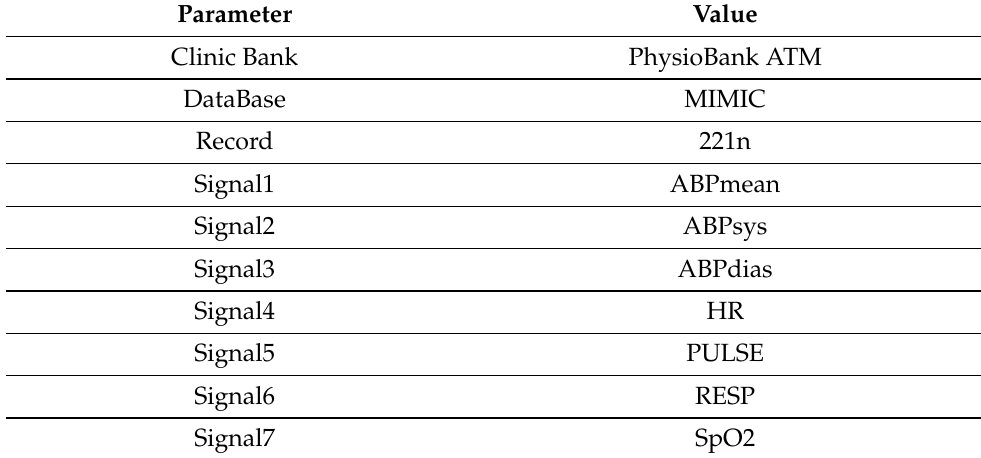
Table 1. Experiment parameters.